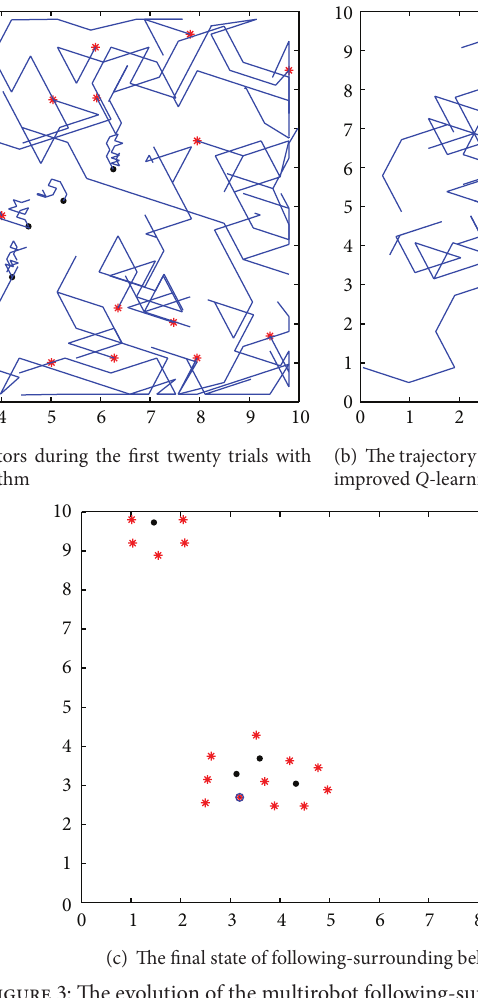
Figure 3: The evolution of the multirobot following-surrounding